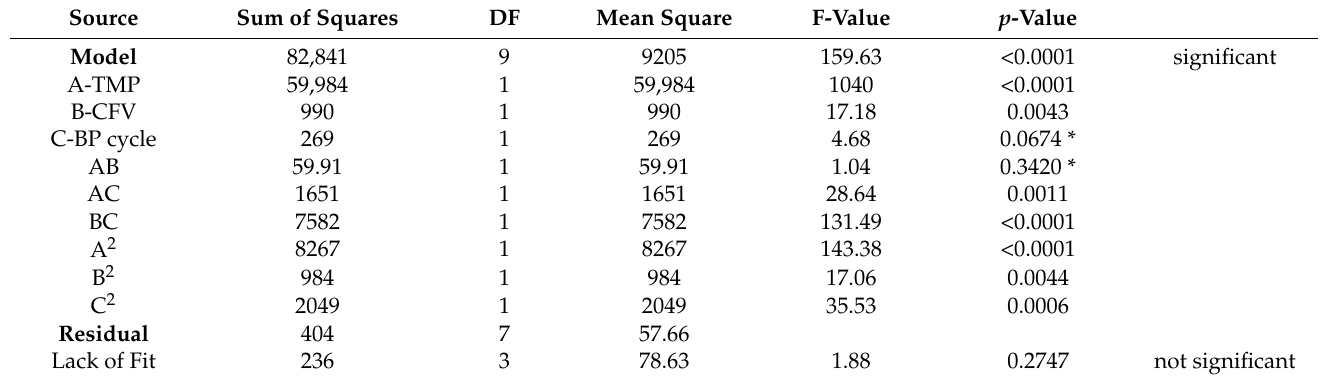
Table 12. ANOVA for the fit of membrane permeate flux.